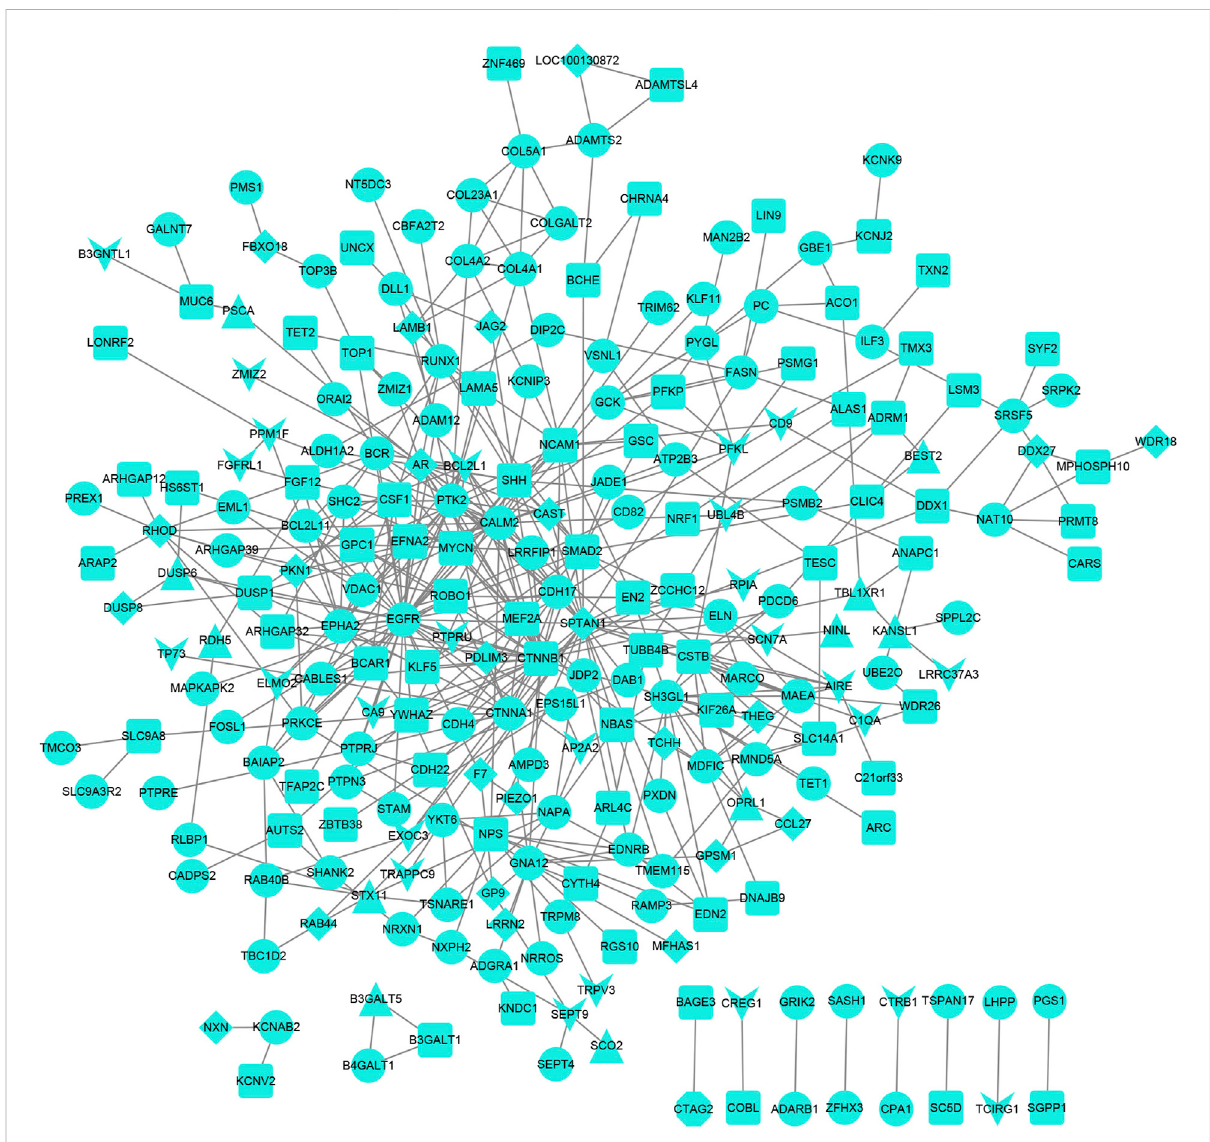
FIGURE 4 Protein – protein interaction network. The V-shaped node represents the promoter, the triangular node represents the UTR, the diamond node represents the exon, the circular node represents the intron, and the square node represents the intergenic